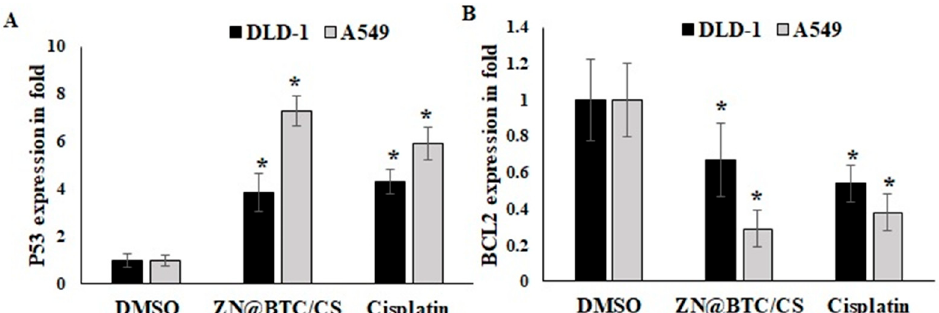
Figure 7. Effect of Zn-BTC@CS on the relative gene expression of ( A ) P53 and ( B ) BCl-2 in lung and colon cancer cell lines. * refers to significant change vs. DMSO